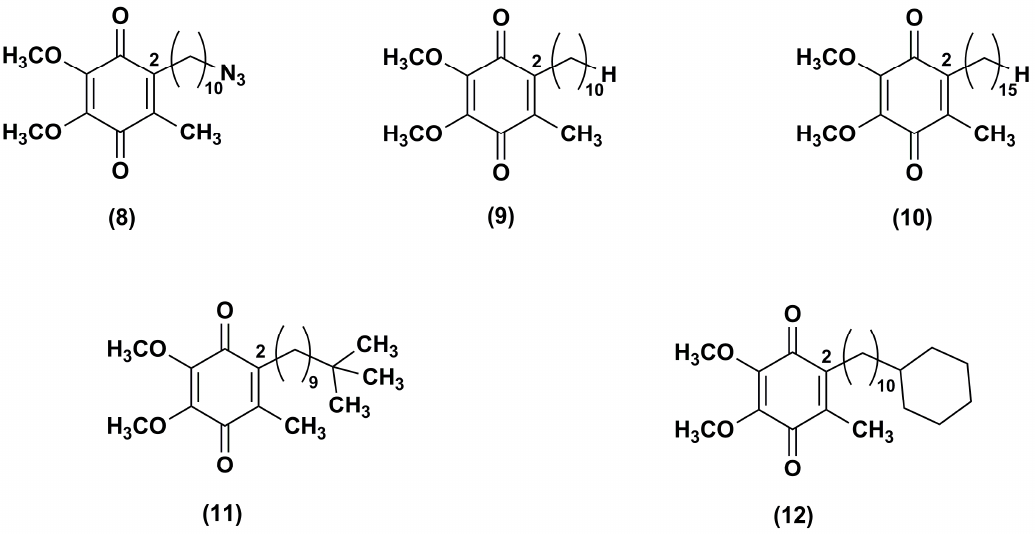
Figure 3. Chemical structures of IDE analogues with side chain modifications at position 2.